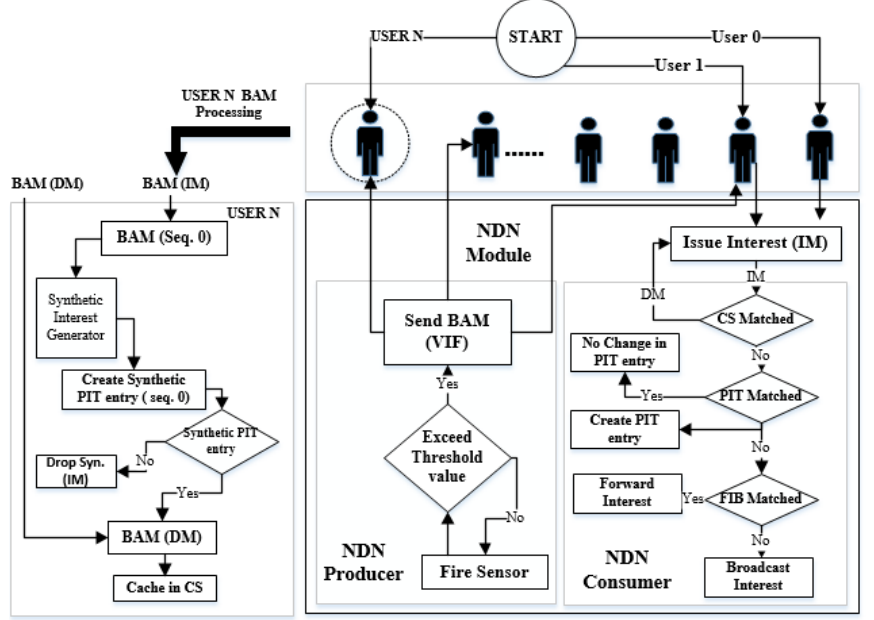
Figure 4. Proposed NDN-DISCA BAM(IM)- > BAM (Interest Message), BAM(DM)- > BAM (Data